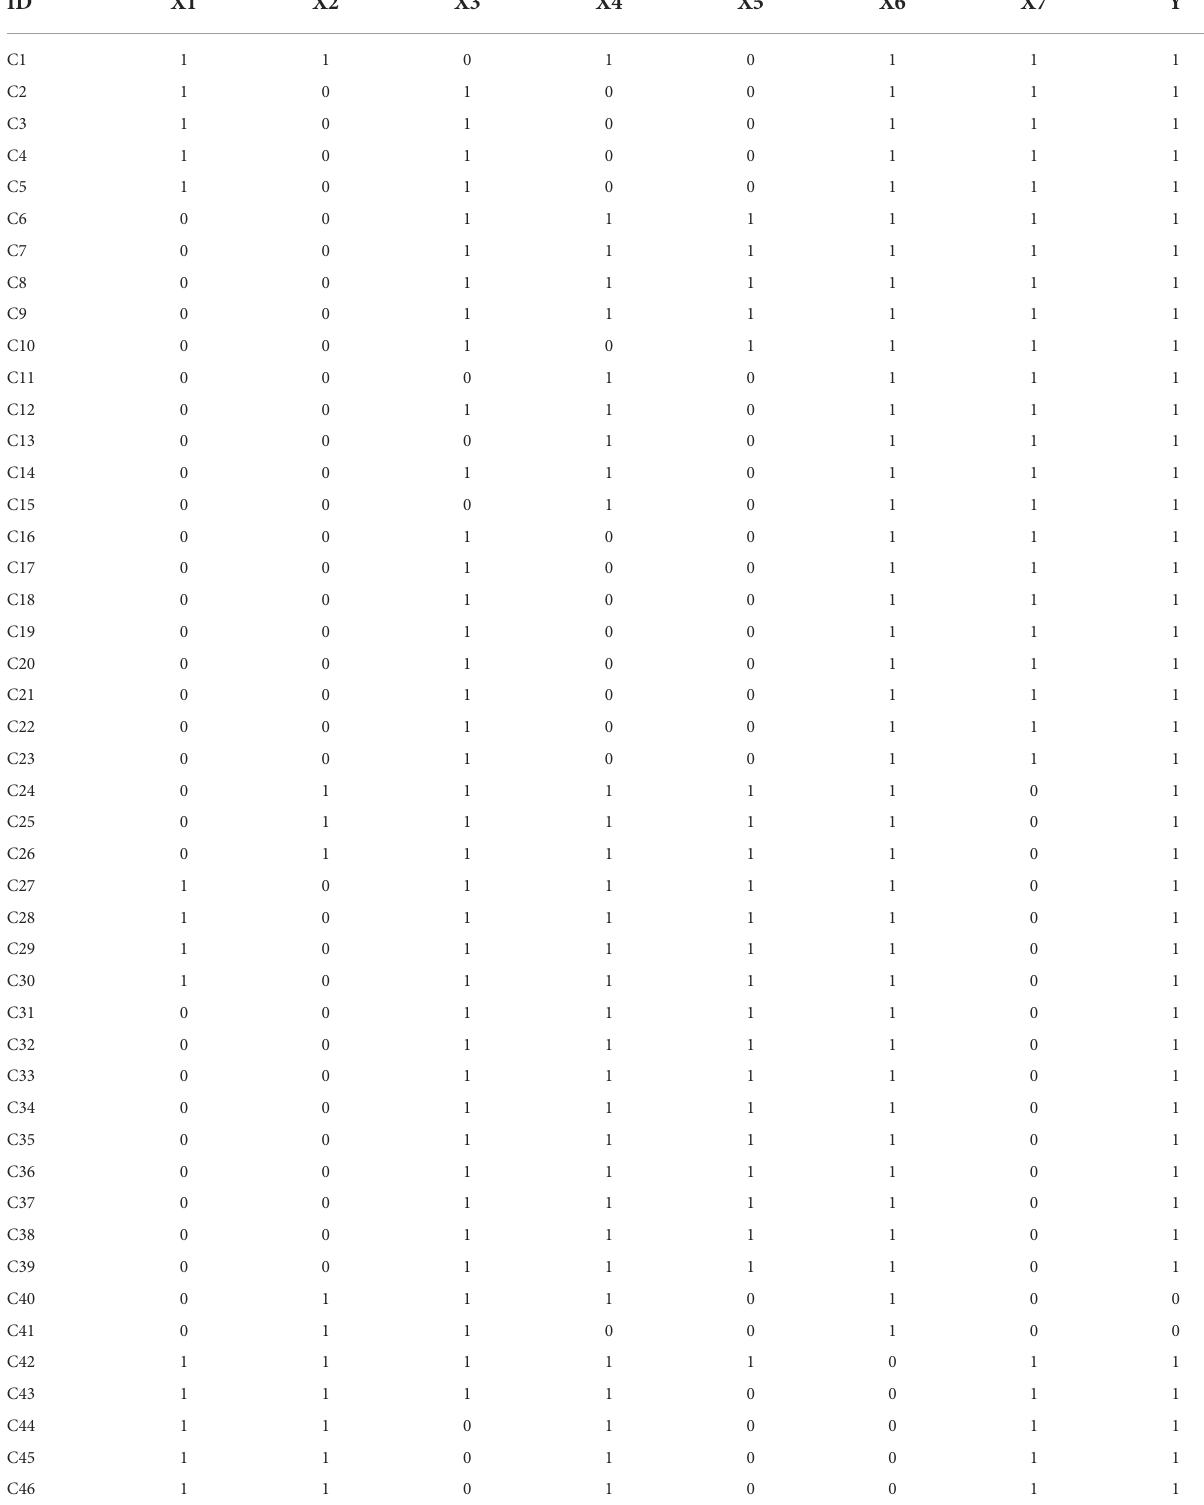
TABLE 2 Truth table for factors influencing integrity education of Chinese college